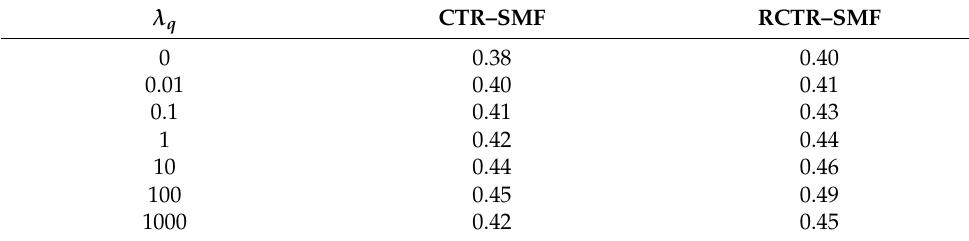
Table 5. Recall Comparison of CTR–SMF and